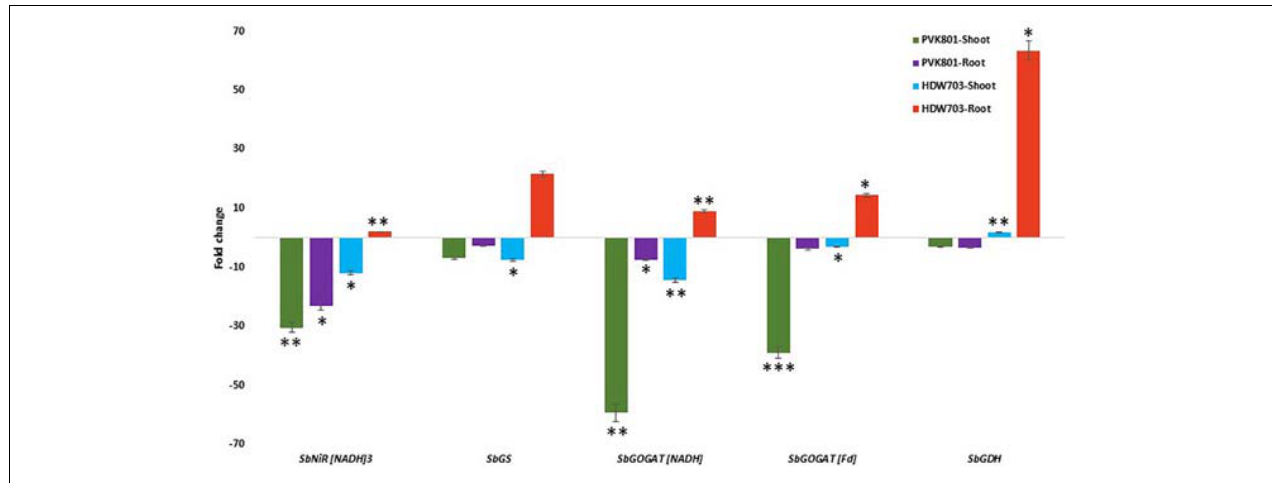
FIGURE 7 | Expression profiles of assimilatory and remobilization related genes in shoot and root samples of high (PVK801) and low NUE (HDW703) genotypes, under N0 condition. Here N0 condition taken as treated and N100 used as control. *, **, and *** denotes significance at 5, 1, and 0.1% P, remaining not significant.